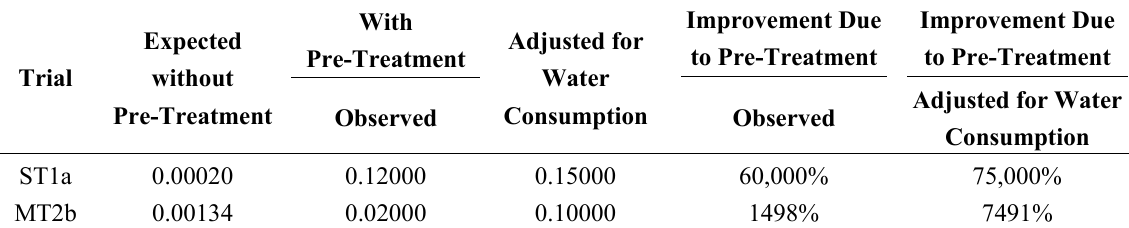
Table 2. Assessed Impact of Pre-Treatment on the desalination rate using [ a t +1 ] is an adjustable variable. Data: Figure 4a–d. Reference data set without pre-treatment: [6,21]: